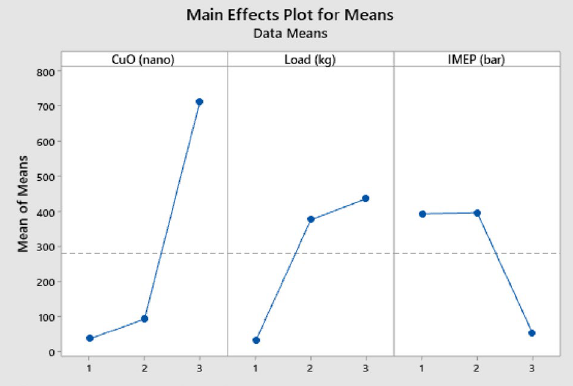
Fig. 11 Investigation by Taguchi: NOx versus CuO (nano), load (kg), IMEP